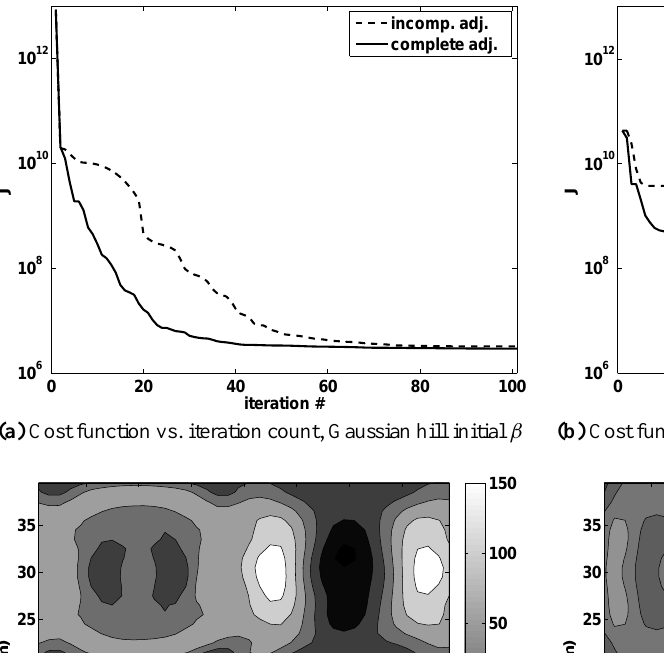
Fig. 3. Jacobian of surface velocities with respect to basal traction values. ∂u(x i ) vertical.